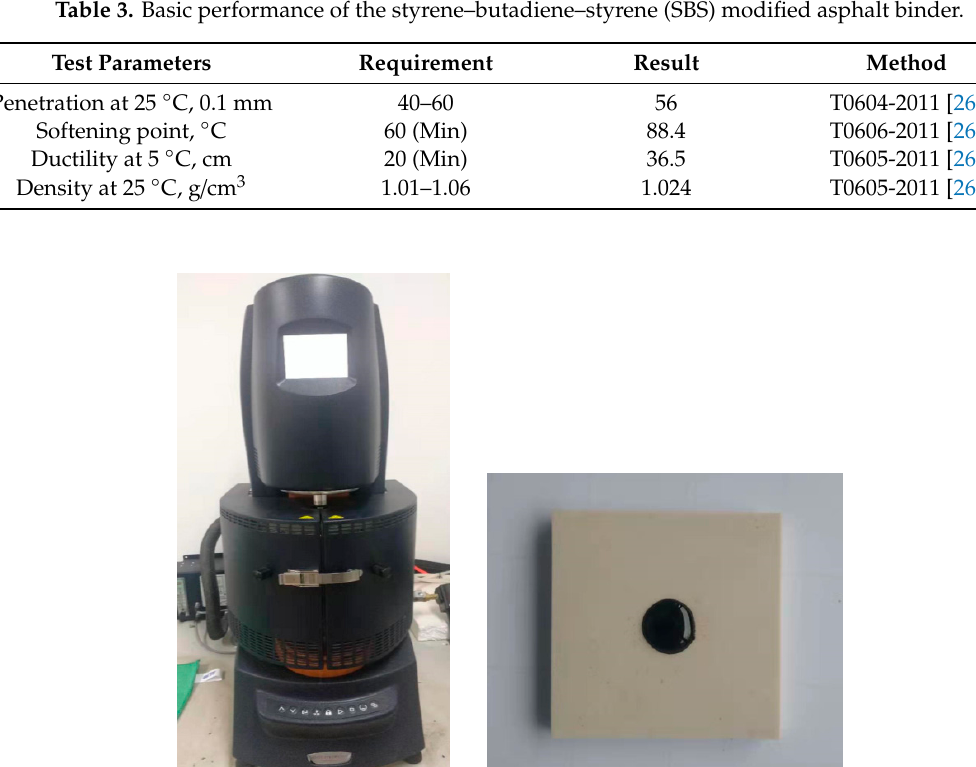
Table 3. Basic performance of the styrene–butadiene–styrene (SBS) modified asphalt binder.